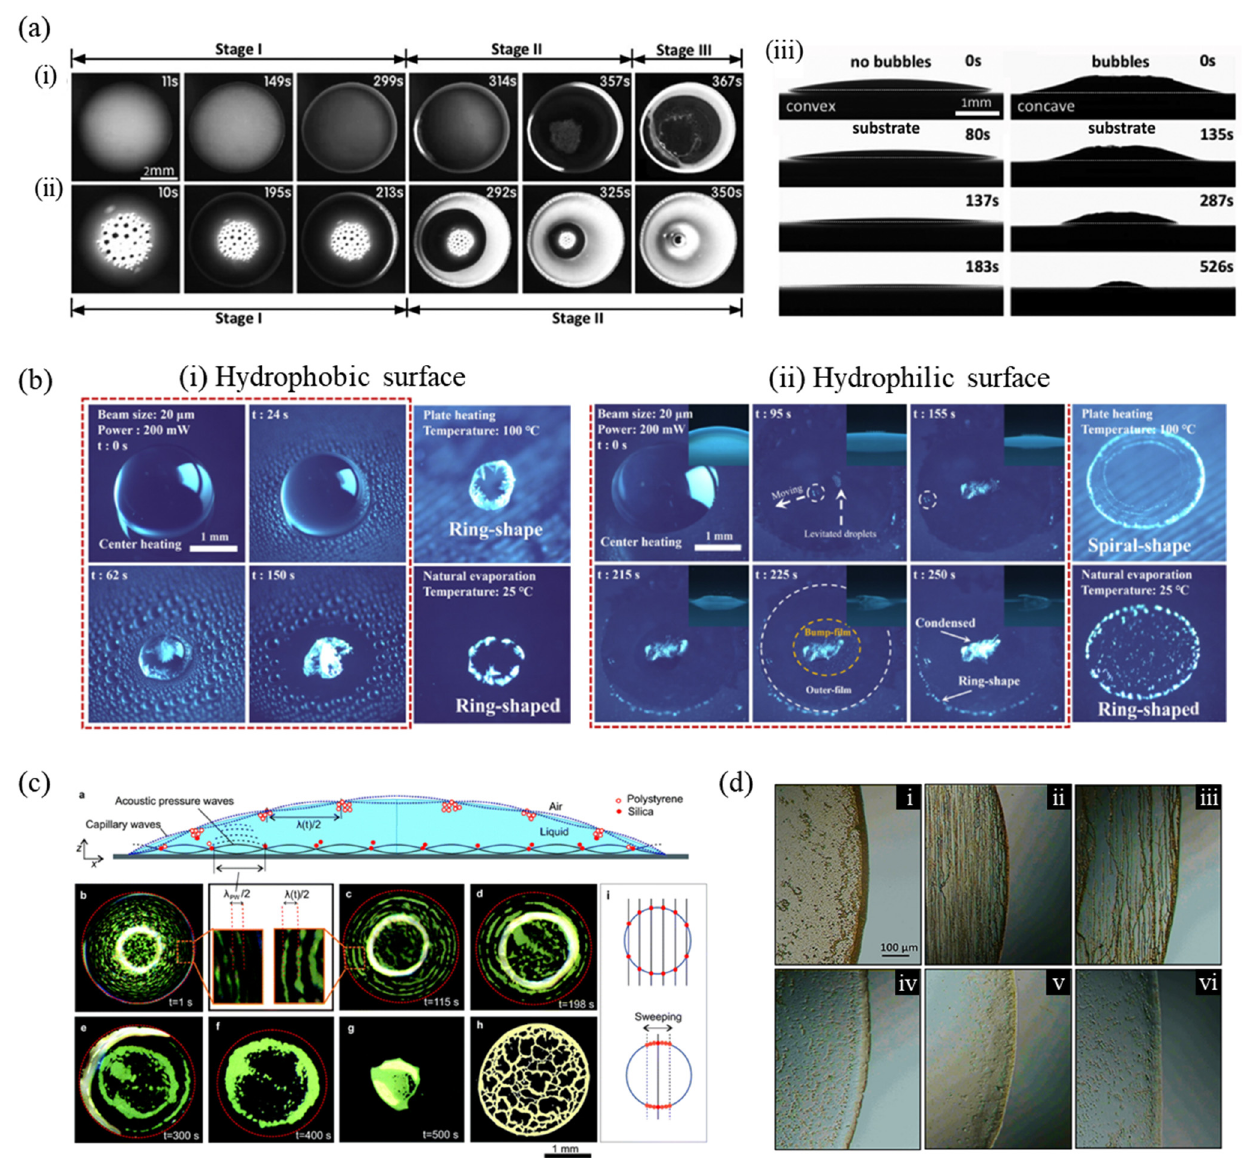
Figure 6. ( a ) Drying procedure of droplets containing polytetrafluoroethylene (PTFE) particles of 60 wt.% (i) without and (ii) with air bubbles on monocrystalline silicon wafers. (iii) Side views of the drying process of a 5 μL droplet with and without bubbles (reproduced with permission from ref. [135]. Copyright 2020 Elsevier). ( b ) Evaporative crystallization process of the light-induced droplet and final deposition patterns under the light-induced, plate-heating-induced, and natural evaporation on the (i) hydrophobic and (ii) hydrophilic surfaces (reproduced with permission from ref. [136]. Copyright 2021 American Chemical Society). ( c ) Schematic illustration of a droplet excited by SAW and images showing the drying patterns of a colloidal drop under SAW with time (reproduced with permission from ref. [52]. Copyright 2015 Royal Society of Chemistry). ( d ) Effect of the applied magnetic field on the ring thickness. (i) 0 T, (ii) 0.005 T, (iii) 0.02 T, (iv) 0.07 T, (v) 0.1 T, and (vi) 0.15 T (reproduced with permission from ref. [107]. Copyright 2017 AIP Publishing).